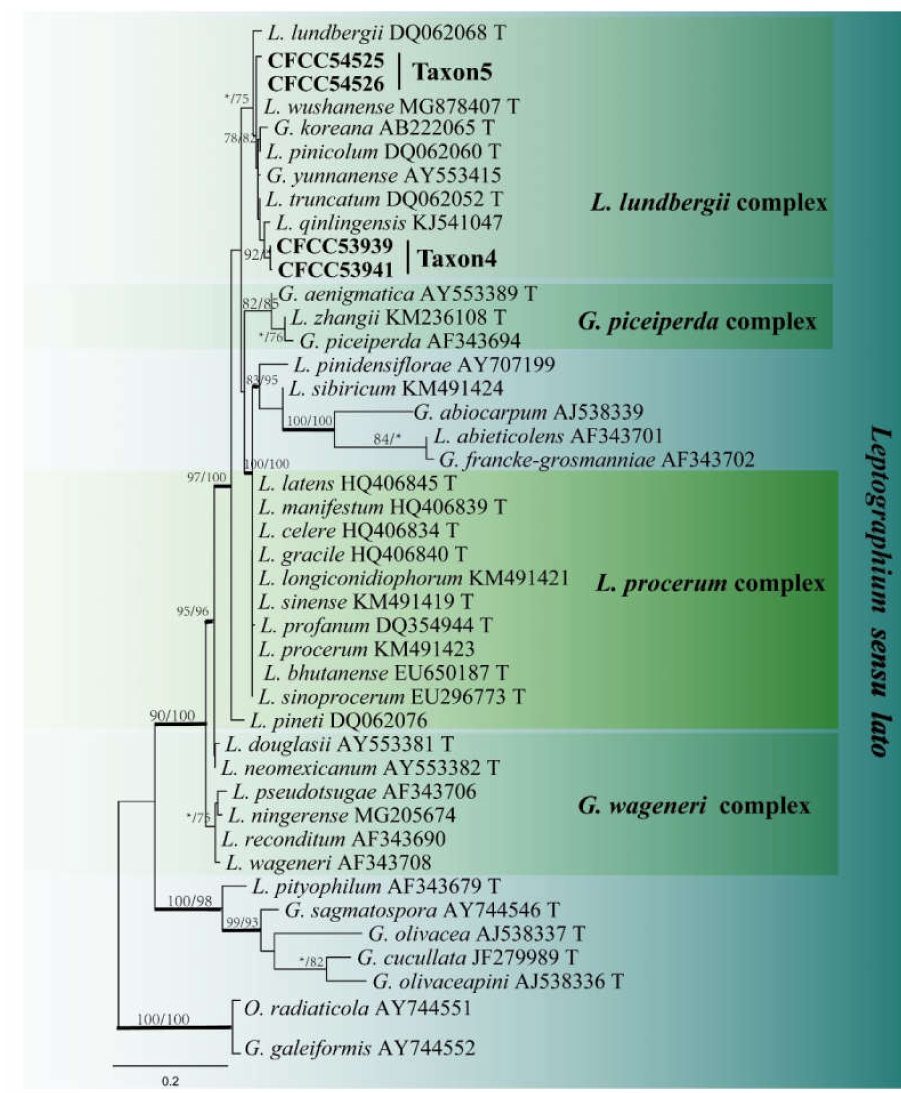
Figure 4. ML tree of Leptographium sensu lato (Taxa 4 and 5) generated from the ITS2-LSU sequence data. Novel sequences obtained in this study are presented in bold typeface. Bold branches indicate posterior probability values ≥ 0.9. Bootstrap values ≥ 70% for ML and MP are indicated above branches. Bootstrap values < 70% are indicated by *. Strains representing ex-type sequences are marked with